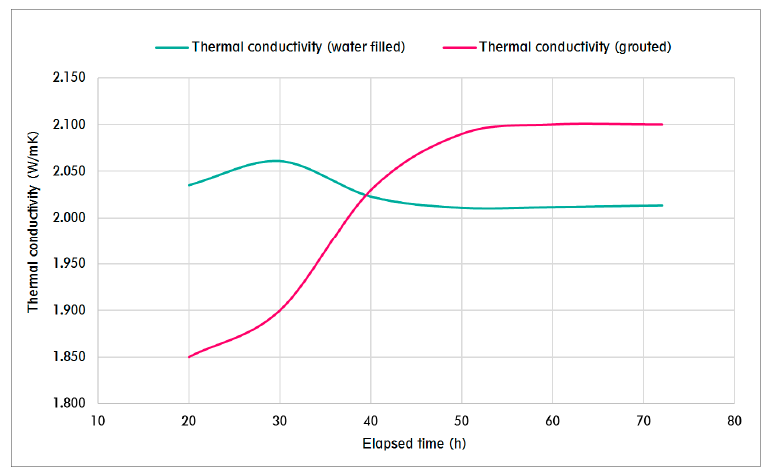
Figure 12. Comparison between thermal conductivity evolutions.